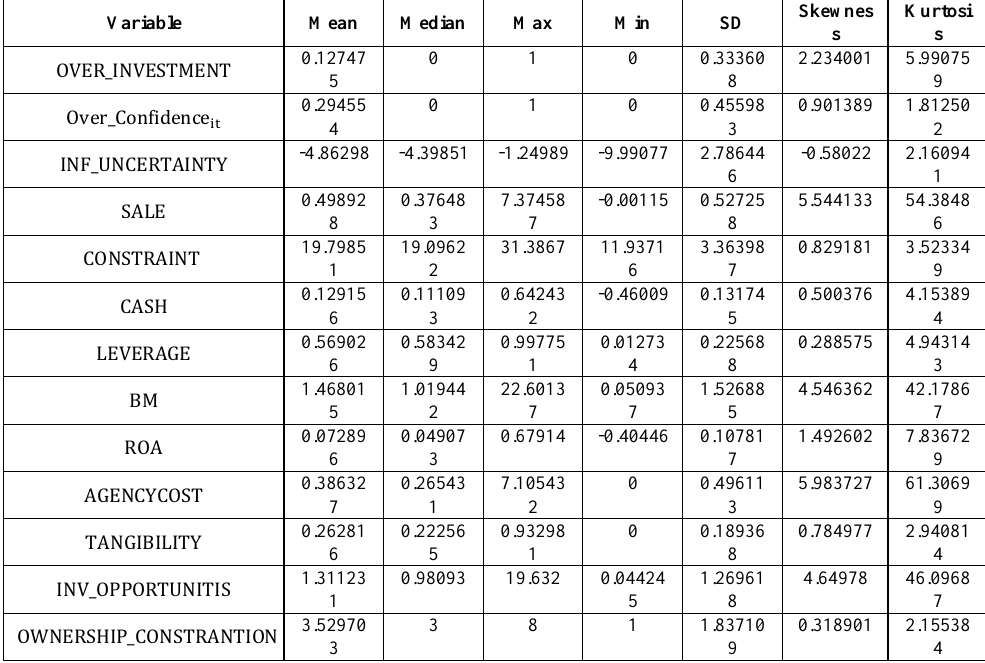
Table 2. Descriptive statistics of research